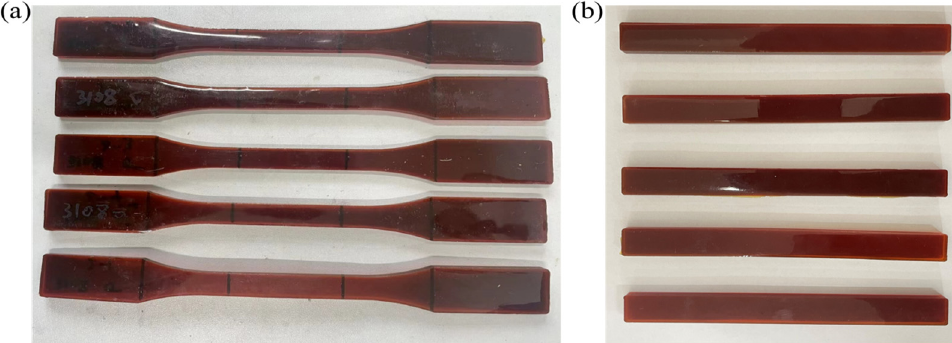
Figure 1. The geometric size of the specimen: ( a ) tensile test specimen, ( b ) bending test specimen.